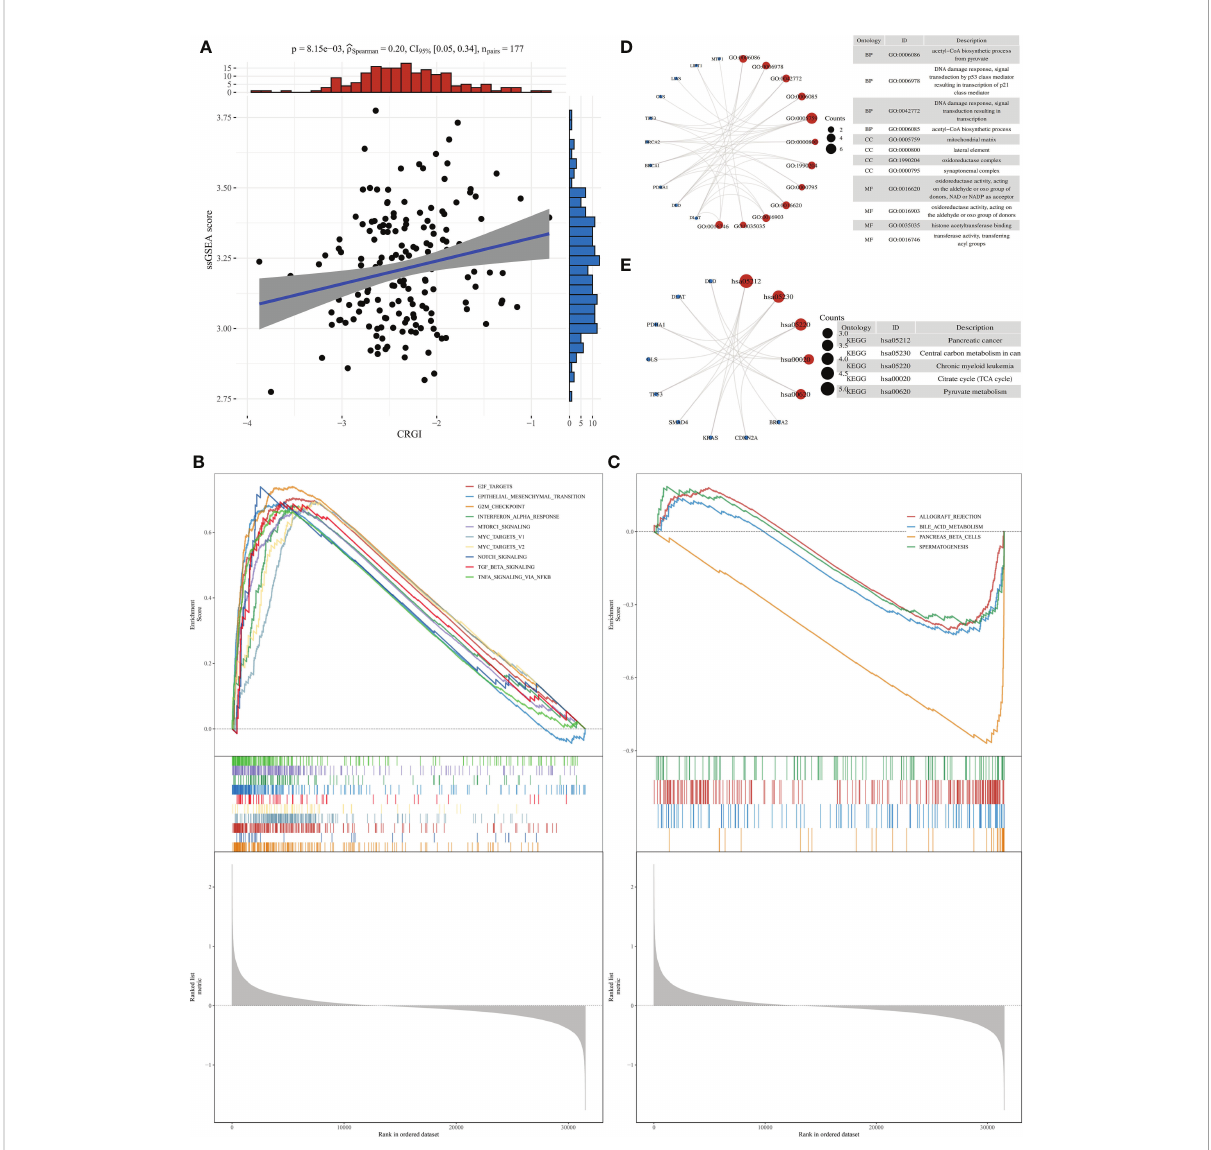
FIGURE 5 Over-representation analysis of CRGI in PAAD. (A) Correlation analysis of the CRGI and ssGSEA score. (B) The top 10 most enriched and upregulated cancer hallmarks in the high-CRGI group. (C) The 4 downregulated cancer hallmarks in the low-CRGI group. (D) The enriched GO terms of CRGI genes. (E) The enriched KEGG pathways of CRGI